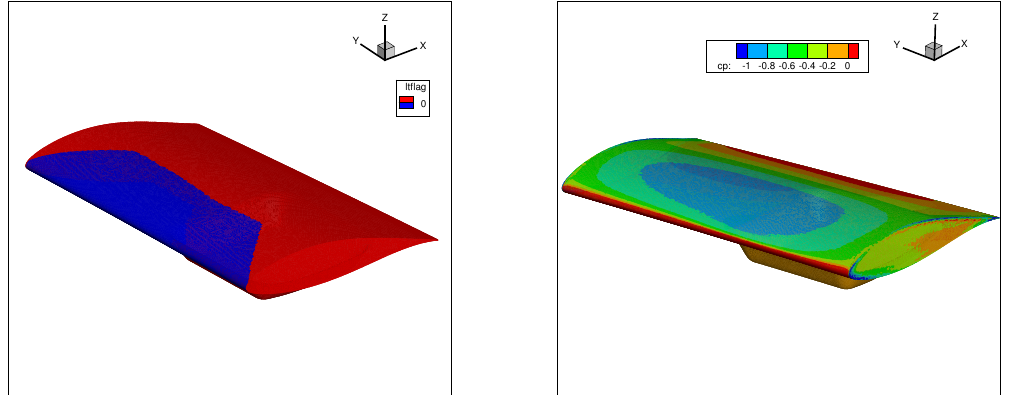
Figure 10. ( Left ): Estimated flow state regions from 3D transitional computational fluid dynamics (CFD), DLR -TAU code). ( Blue ) Laminar flow; ( Red ) fully turbulent flow. ( Right ): Static pressure